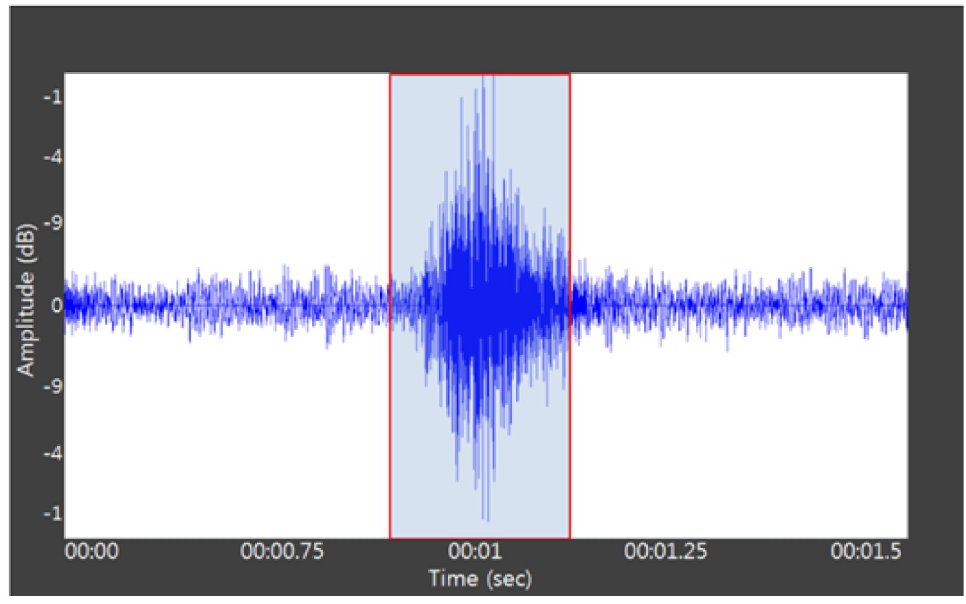
Fig 3. Data processing results